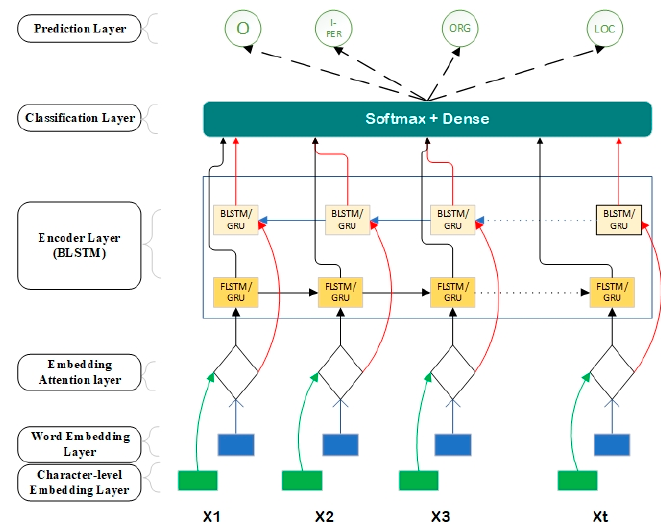
Figure 1. Main architecture of the network. Word embedding is provided to a Bi-LSTM/GRU. The forward unit represents the word X t and its left context, whereas the backward unit represents the word X t and its right context. Concatenating the two vectors yields a representation of the word X t and its context, and this embedded representation is fed to the classification